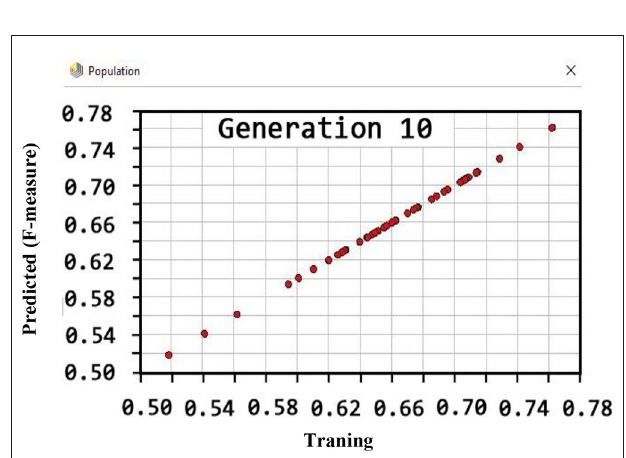
FIGURE 4 | ACC diagram for GSVMA method for generation 10.